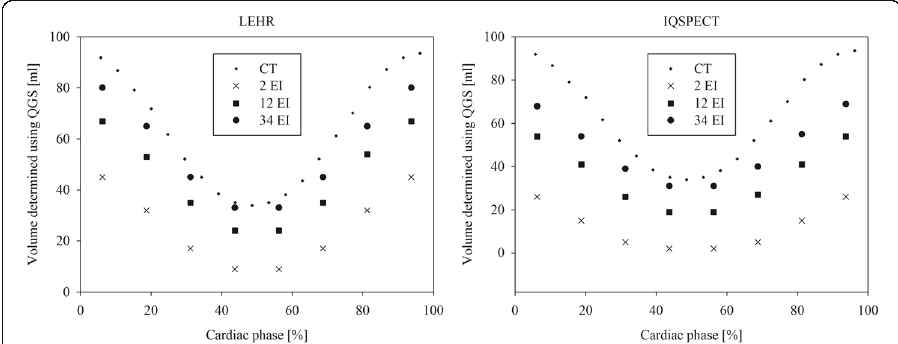
Fig. 7 Cardiac phantom volume estimates for LEHR and IQ-SPECT protocols compared with corresponding CT measurements ( small dot ) with phantom EF setting 65%. The effect of the number of reconstruction iterations (EI) is shown with different markers ( cross = 2, square = 12 and large dot =